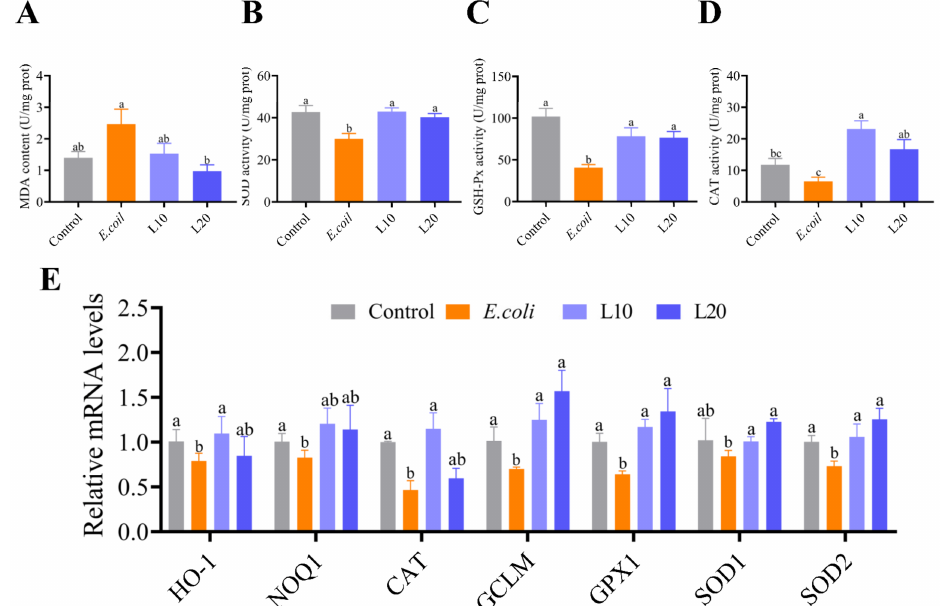
Figure 4. Effects of luteolin on oxidative stress in chicken ileum tissue. ( A ) MDA content, ( B ) SOD activity, ( C ) GSH-Px activity, ( D ) CAT activity, and ( E ) The mRNA expression levels related to antiox- idant genes. The data are expressed as mean ± SD. A statistical difference ( p < 0.05) demonstrated using different